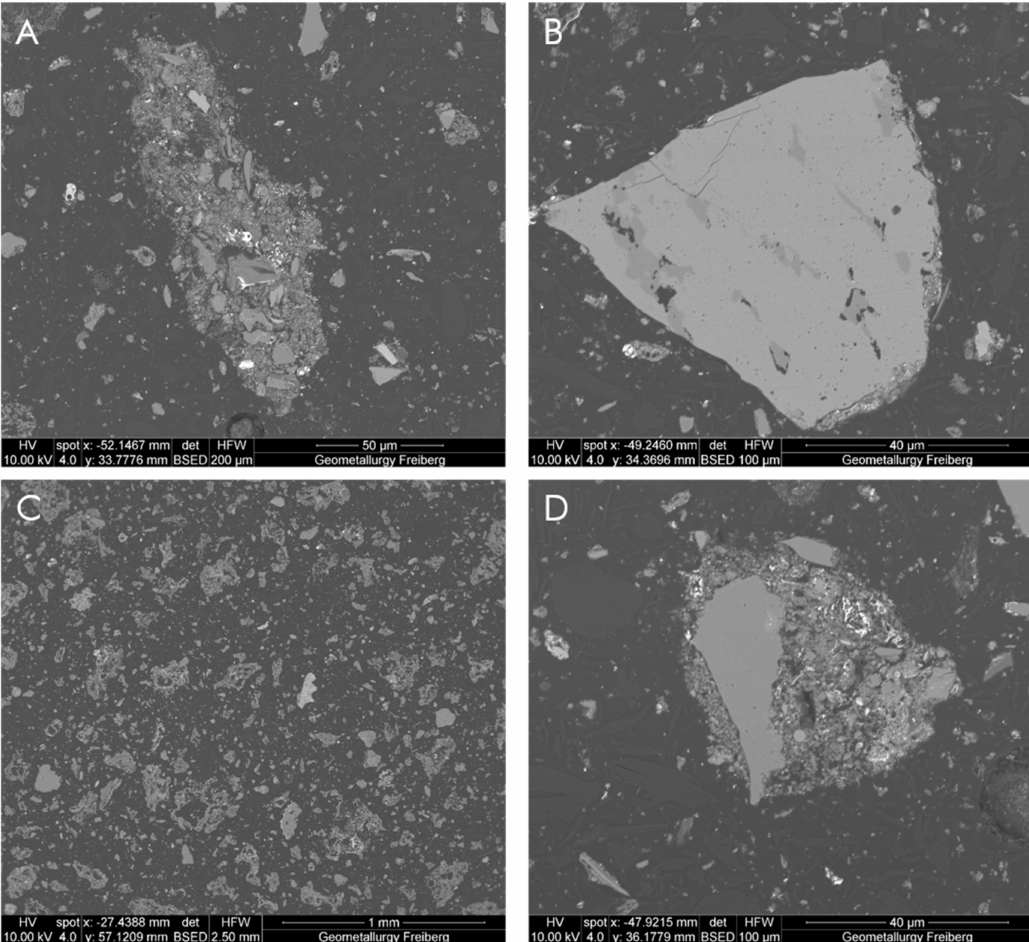
Figure 1. BSE images of sewage sludge ash mixed with graphite for particle separation and stabilized with epoxy for analysis. ( A ) agglomeration of fine flakes; ( B ) inherited mineral grain, presumably from fluidized bed, bottom right of the grain shows P-rich material condensing onto grain; ( C ) general overview of SSA and ( D ) agglomeration around inherited